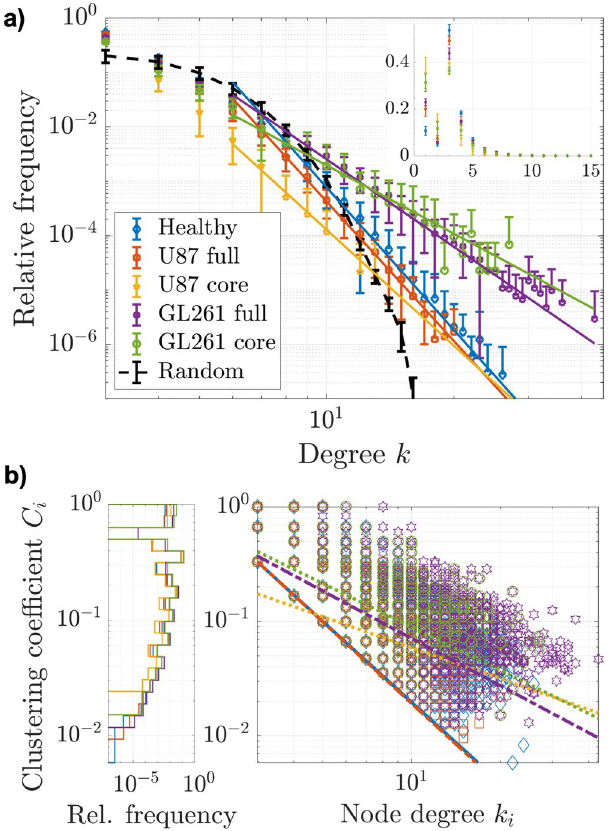
Figure 2. Vascular network topology. ( a ) Degree distributions (mean with SD among samples) from n = 6 healthy brain hemispheres, full U87 and GL261 tumors, and tumor cores, respectively. For comparison, the mean degree distribution from = n 12 random Erdös-Rényi graphs 66 with the corresponding node and edge r numbers, is displayed as well, following a Poisson distribution. The large plot presents the distributions for ≥ k 3 on logarithmic axes, while the inlayed plot shows the full distributions on linear scales. The logarithmic plot includes straight lines in corresponding colors, representing power law fits to the vascular data. ( b ) Bivariate distributions of node clustering coefficients C i with corresponding node degrees k i , including all nodes with ≥ k 3 from all datasets and power law fits in corresponding colors. The marginal distributions of clustering coefficients C i are displayed with a logarithmic ordinate axis to better illustrate differences along the entire